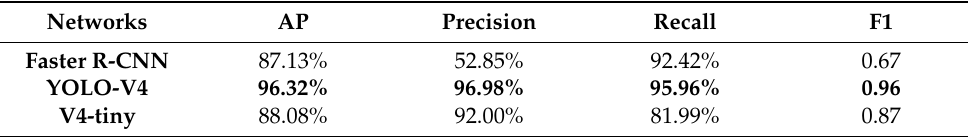
Table 4. Comparison of ship testing indicators on